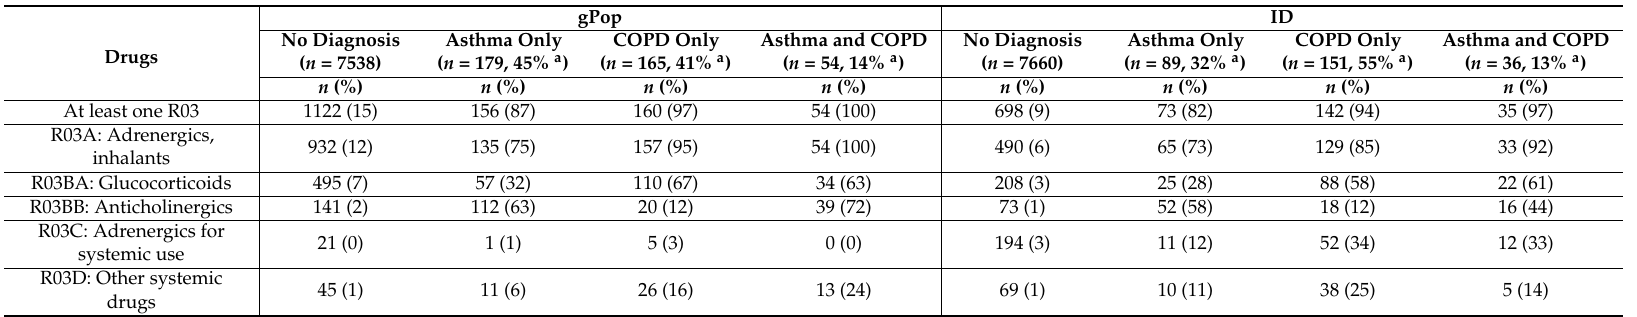
Table 4. Prescription of drugs for obstructive airway diseases stratified by diagnoses of asthma and chronic obstructive airway disease in a cohort of people with intellectual disabilities (ID) and a referent sample from the general population